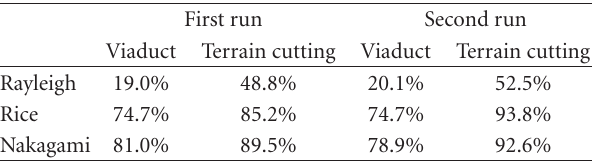
Table 2: K-S testing results at 5% significance level.